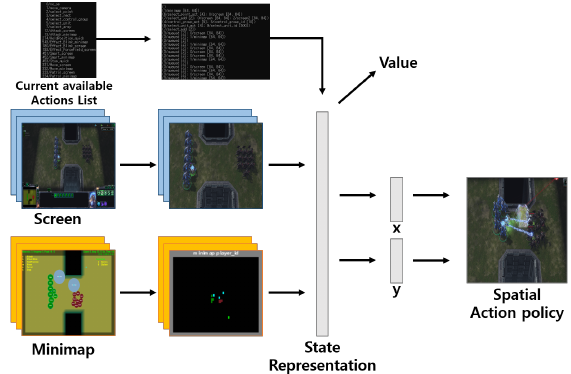
Figure 2. Atari network architecture in the StarCraft II minigame.